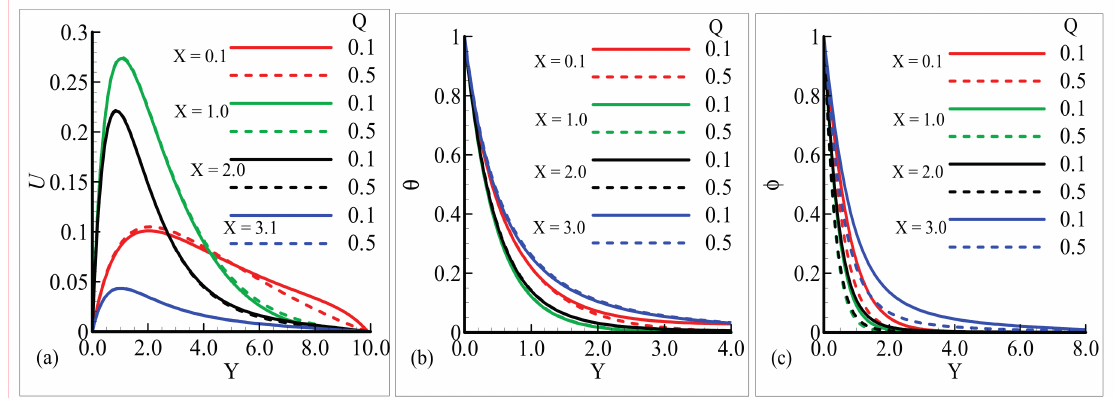
Figure 3. Physical e ff ects on quantities ( a ) U , ( b ) θ , and ( c ) ϕ versus Q , when Nt = 0.02, Nb = 0.4, Pr = 0.72, M = 0.2, Sc =